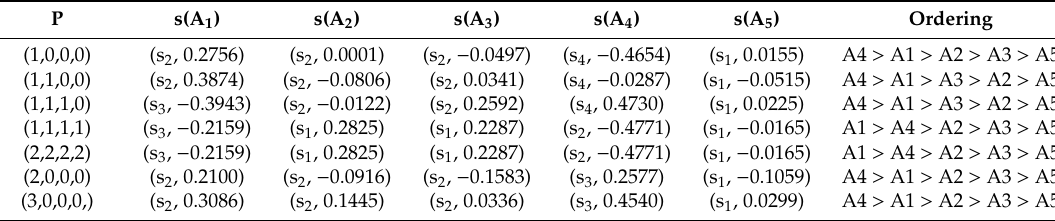
Table 6. Ranking results for di ff erent parameters of the SVN2TLWDMM operator.